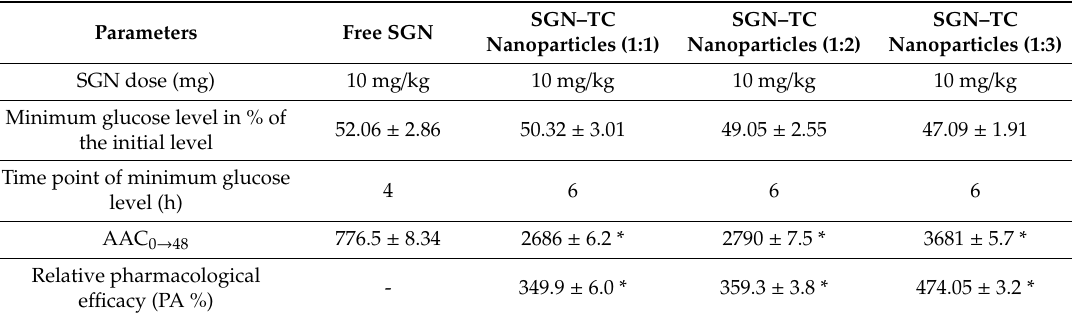
Table 7. The relative pharmacological e ffi cacy of SGN–TC